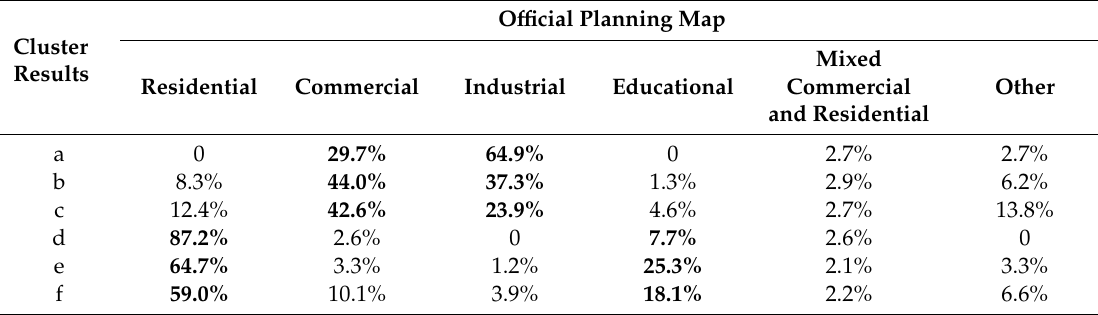
Table 3. Percentage of overlap between the o ffi cial planning maps and the cluster results for Hangzhou. O ffi cial Planning Map Cluster Results Residential Commercial Industrial Educational